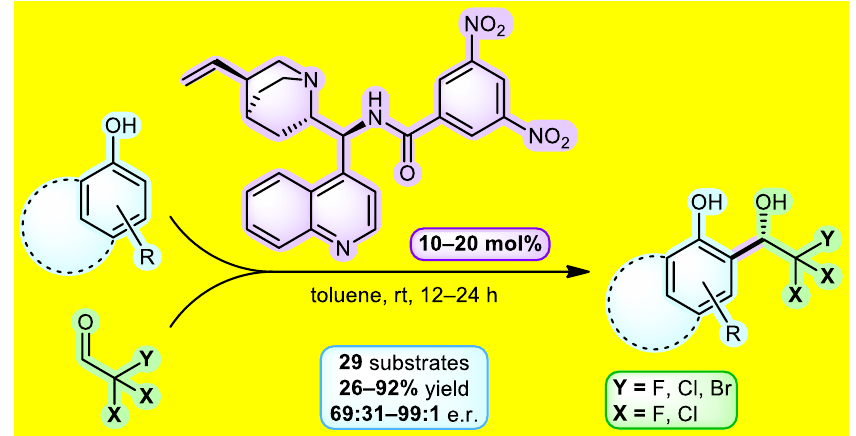
Figure 1. Reaction scheme for obtaining trihaloethanols.